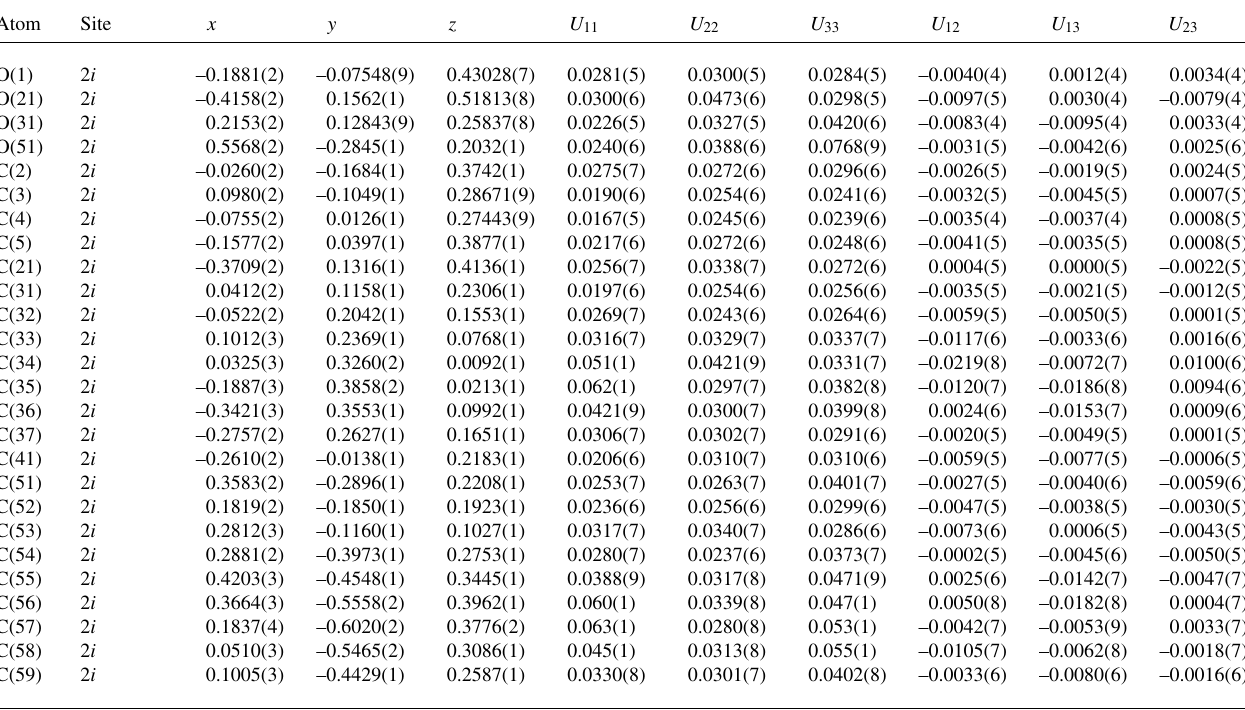
Table 3. Atomic coordinates and displacement parameters (in Å 2 )